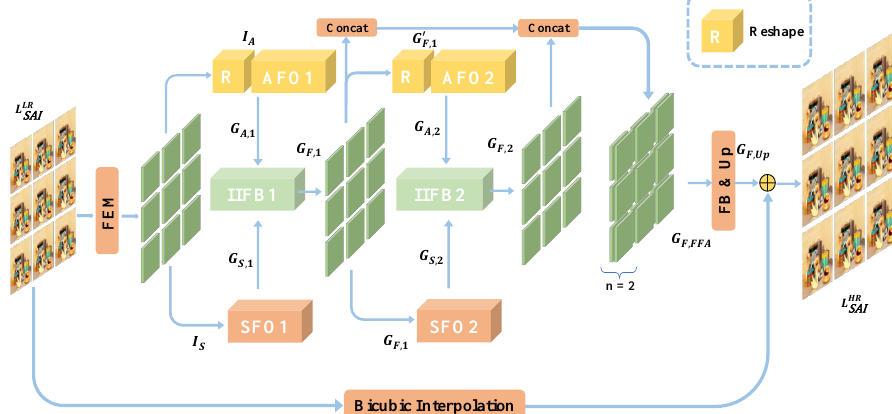
Figure 2. Overview of the proposed LF-FANet. The input of our network consists of SAIs with dimensions N × C × H × W . The reshape operation (R) represents the reshape operation between angular-wise and spatial-wise. The number of the key components (AFO, SFO, IIFB) is